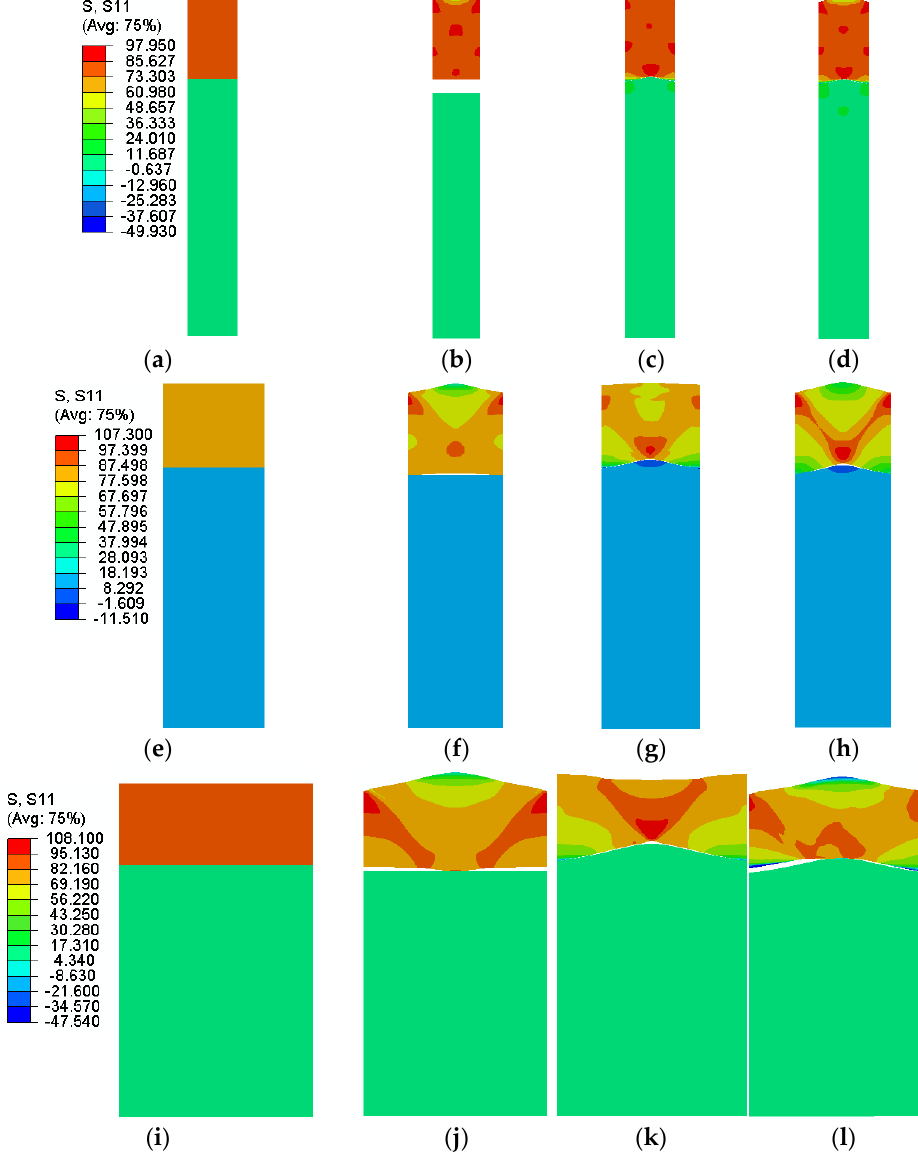
Figure 6. Distribution of stress parallel to the loading direction ( 𝑠 11) at maximum stress for the laminate with a wavelength of ( a – d ) h/2, ( e – h ) h, ( i – l ) 2 h and ( a , e , i ) without roughness, ( b , f , j ) with wavy Al surface, ( c , g , k ) with wavy LDPE surface and ( d , h , l ) with both Al foil and LDPE wavy surfaces.